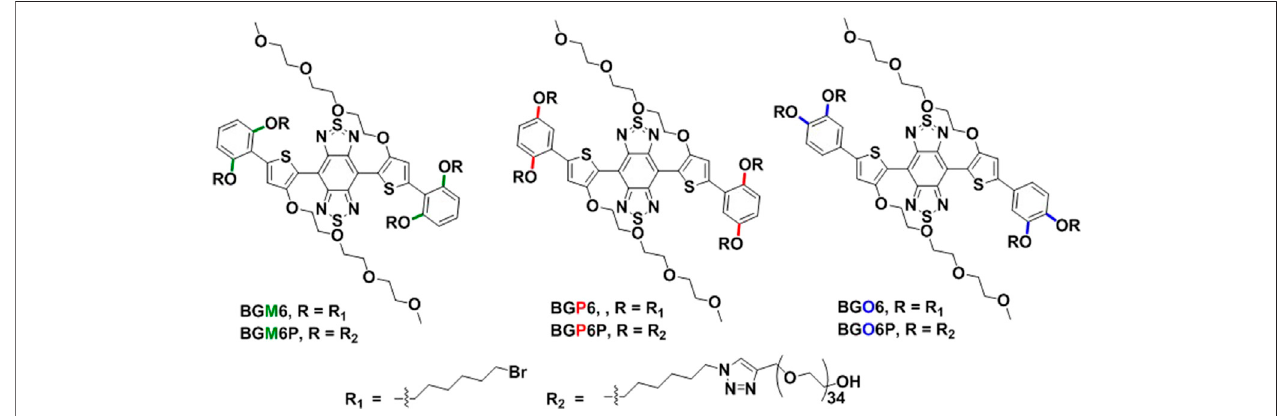
FIGURE 1 | Structures of the S-D-A-D-S molecular fl